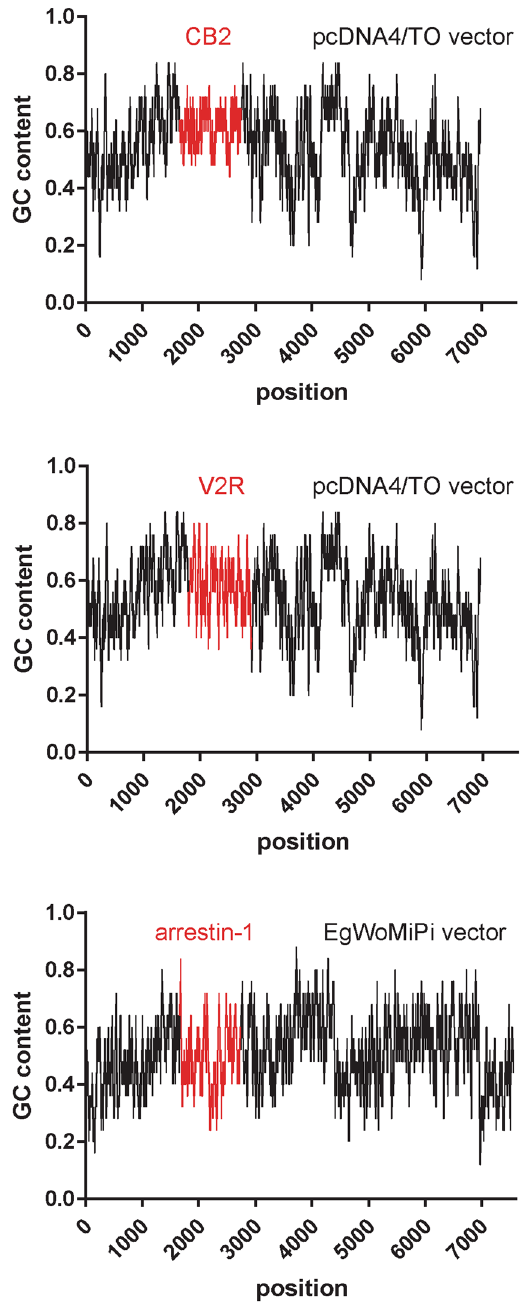
Figure 6. GC content of the plasmids used for the generation of the mutagenesis libraries. For each nucleotide position in the plasmid sequence, GC content was calculated using a 25 bp sliding window. The mutated sequences are highlighted in